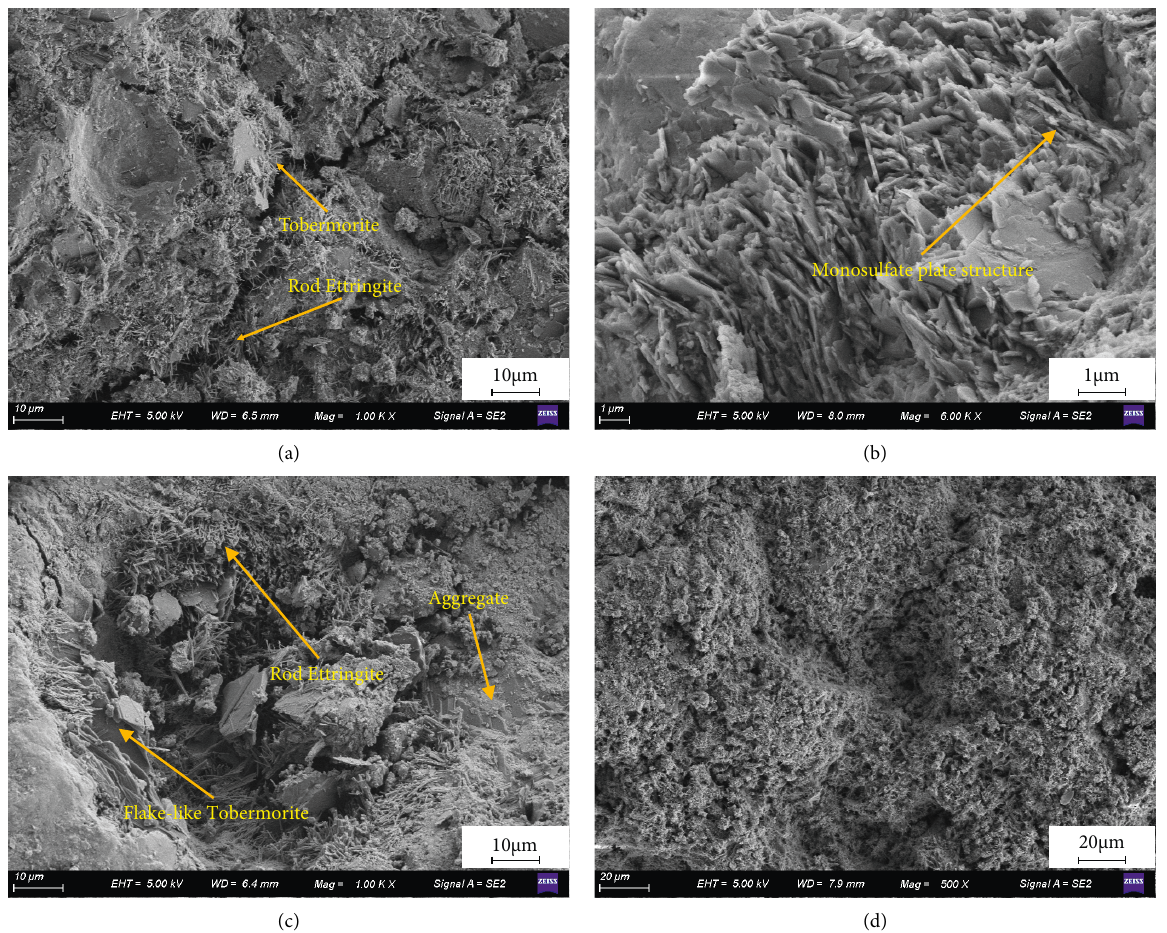
Figure 14: Microscopic damage characteristic diagram of samples (IOT replacement rate is 0%) under 200 F-T cycles: (a) RAC0-IOT0; (b) RAC3-IOT0; (c) RAC5-IOT0; (d)